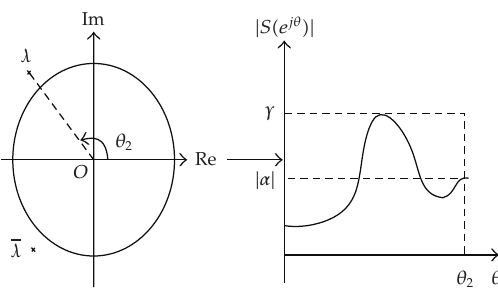
Figure 3: Influences of an extra interpolation constraint S (cid:2) λ (cid:3) (cid:8) α on | S (cid:2) z (cid:3) |